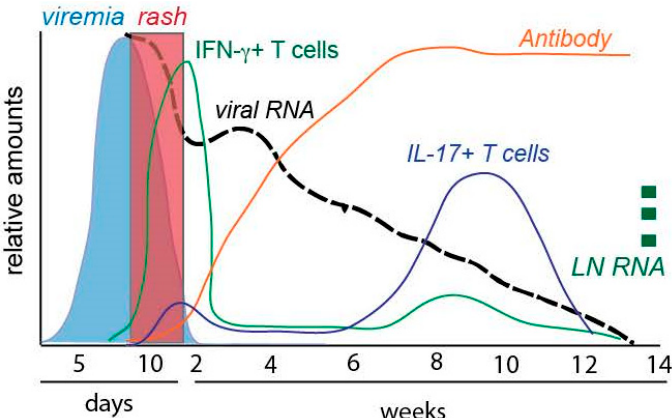
Figure 1. Schematic diagram of measles virus (MeV) clearance and immune responses in rhesus macaques. Infection with wild type (WT) MeV results in viremia (infectious virus) and rash. The rash is associated with appearance of interferon (IFN) ‐γ‐ producing T cells that decline quickly after the viremia is cleared. There is a prolonged phase of slow viral RNA clearance from peripheral blood mononuclear cells (PBMCs) with persistence of viral RNA in lymph nodes (LN). During RNA clearance antibody increases in amount and avidity. Waves of MeV ‐ specific T cells continue to appear in circulation with a shift from IFN ‐γ production to interleukin 17 (IL ‐ 17) production. Data graphed from Lin et al.